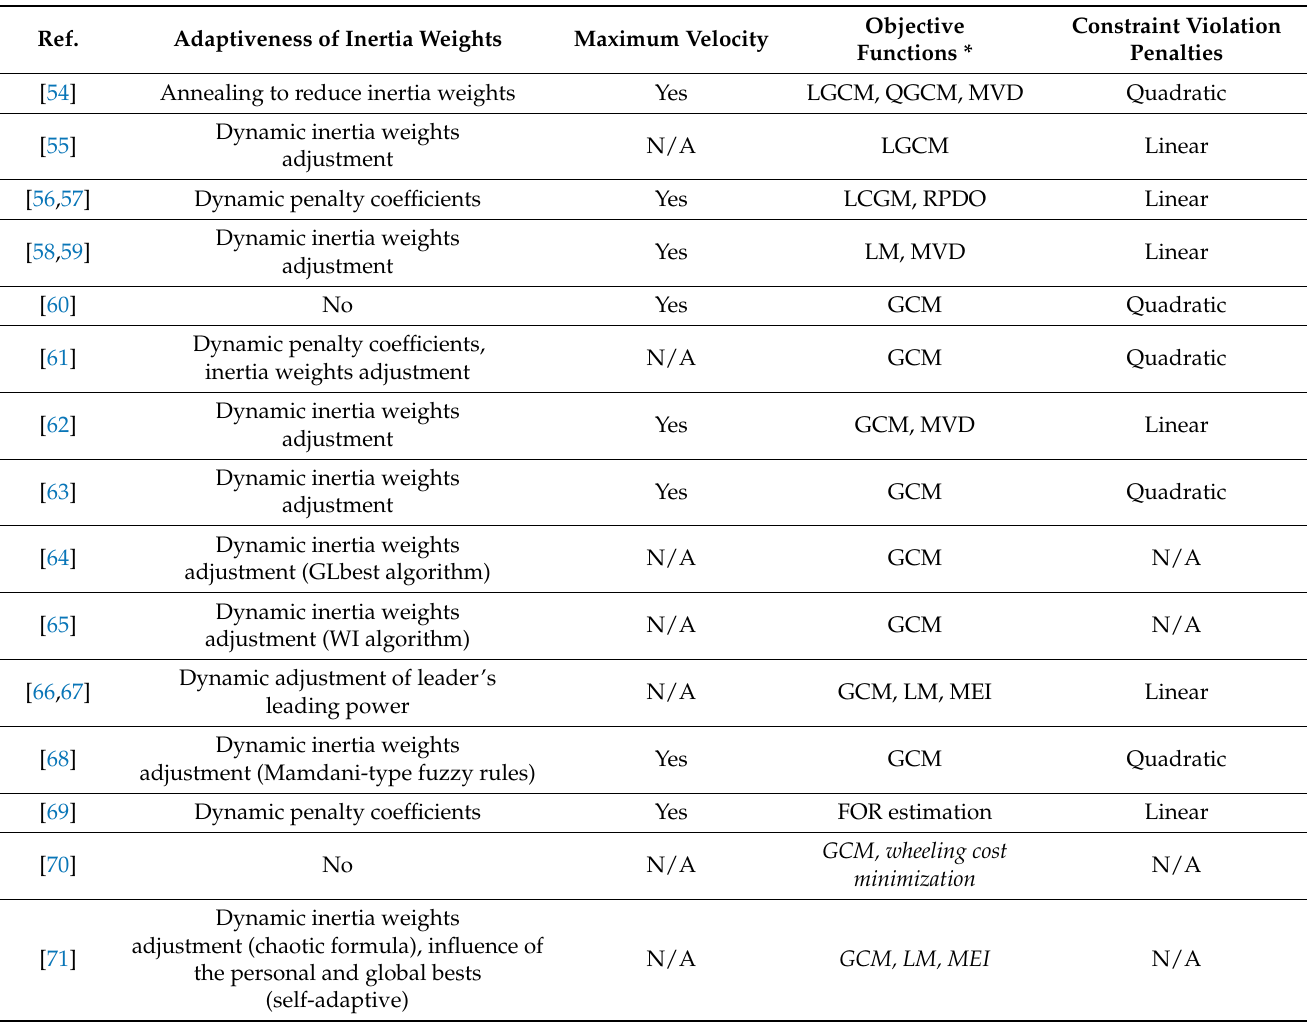
Table 4. Summary of the reviewed PSO OPF